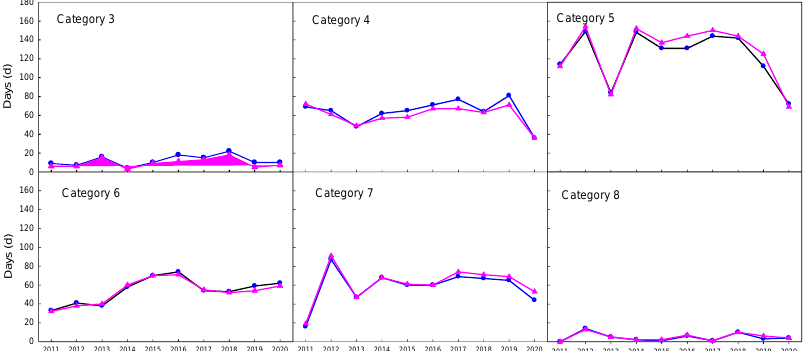
Figure 3. Validation of the radiation estimation and UTCI calculation in Beijing by different methods.